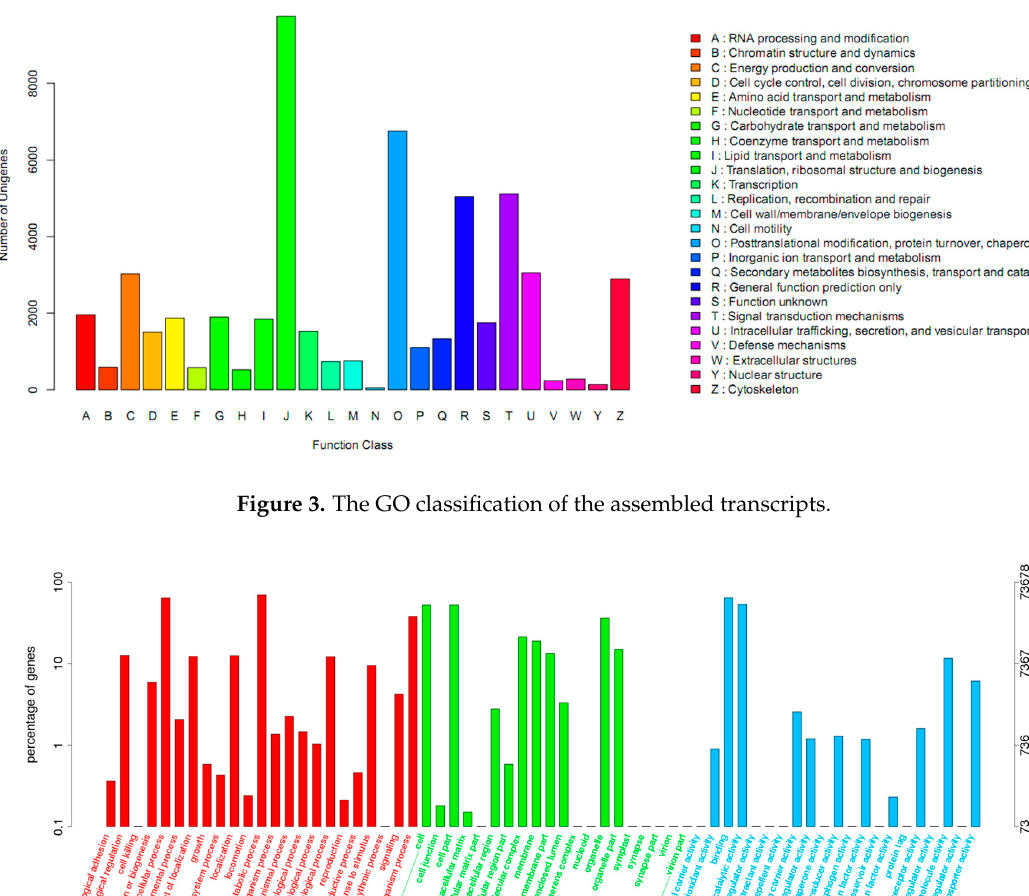
Figure 2. The most represented species distribution.